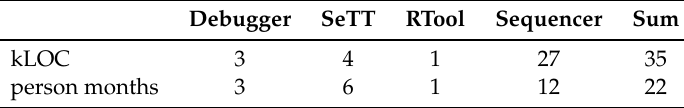
Table 3. Development effort for Sequencer with tool